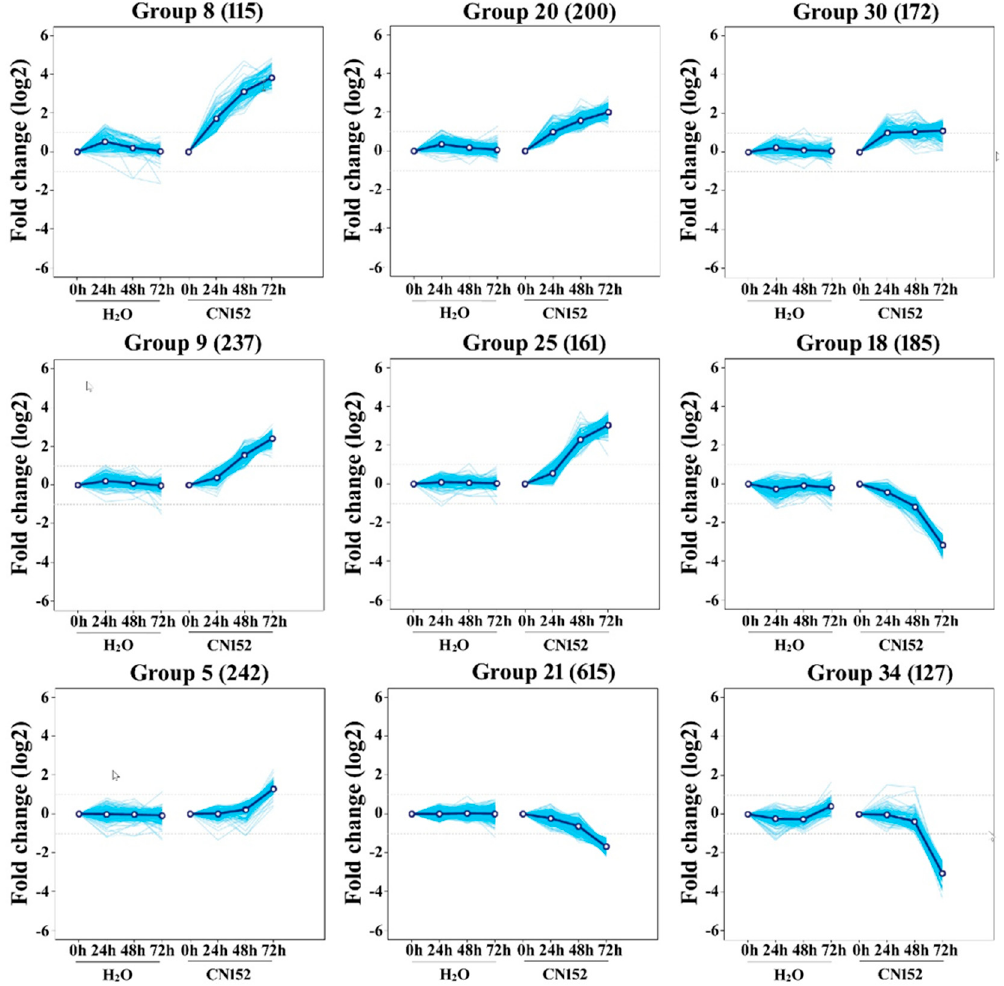
Figure 3. K-means clustering of the differential expression transcription units altered by Phytophthora infestans infection. Group 5, 8, 9, 20, 18, 21, 25, 30, and 34 are the nine representative clusters with different gene profiles; Numbers in the brackets are the number of genes for each group. X -axis, different time points of 0, 24, 48, and 72 h after CN152 inoculation and H 2 O treatment. Y -axis, log2 fold change of genes expression levels in 24, 48, and 72 hpi compared to 0 h; the dotted line means a value of 1.0, which indicates 2-fold greater expression in the cluster of interest.